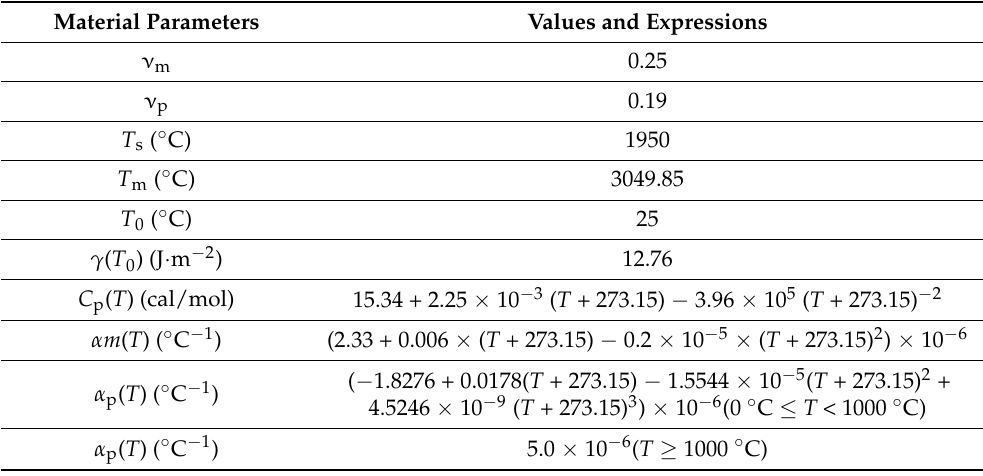
Table 1. Material properties